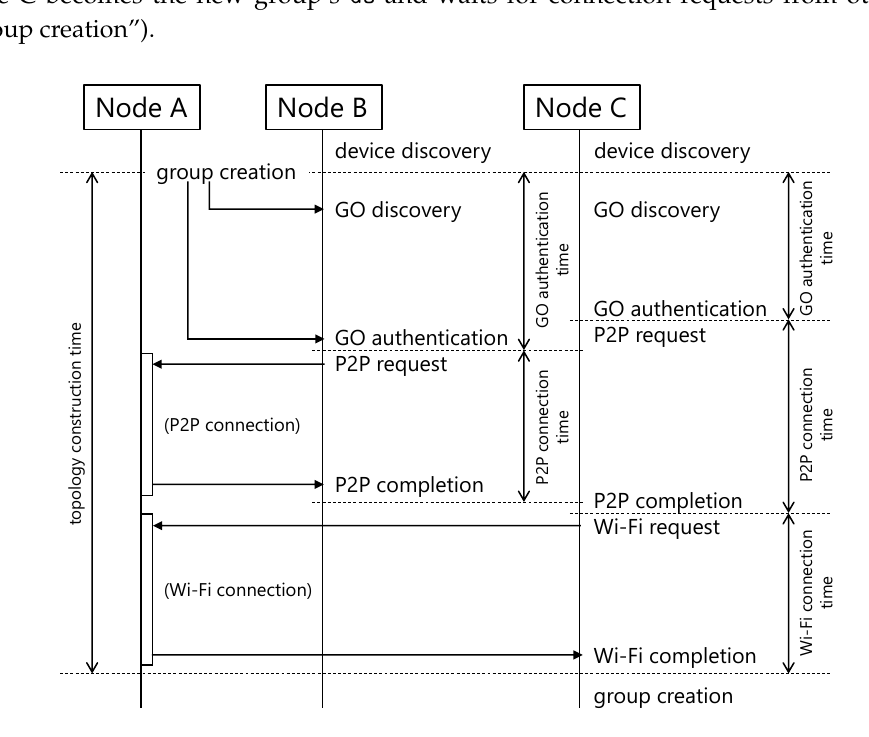
Figure 4. Sequence diagram of topology construction